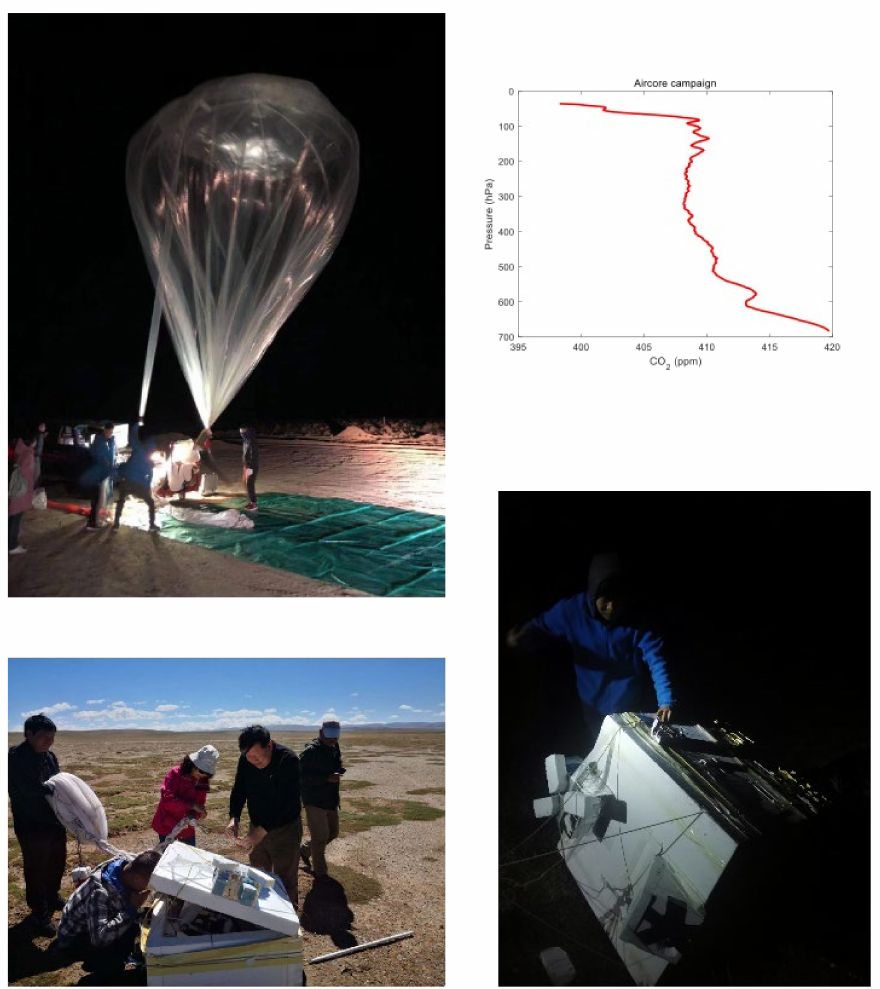
Figure 9. Top right: The launch of AirCore on Tibetan Plateau in 2020. Example of vertical CO 2 profile observations in Dachaidan, Tibetan Plateau during the 2019–2020 AirCore campaign. Top left: Bottom: Recovery of Aerosol sounding and AirCore on Tibetan Plateau in